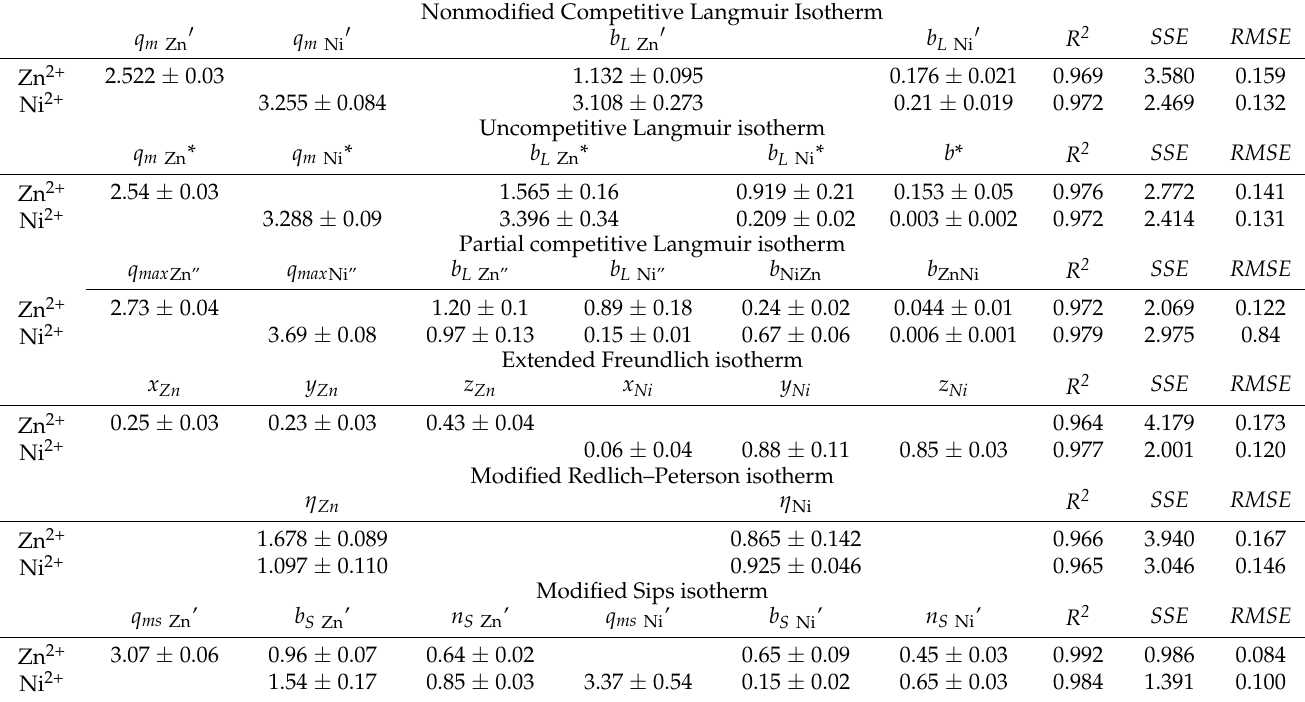
Table 4. Parameters of the binary isotherm models for Zn 2+ and Ni 2+ biosorption onto CS. Nonmodified Competitive Langmuir